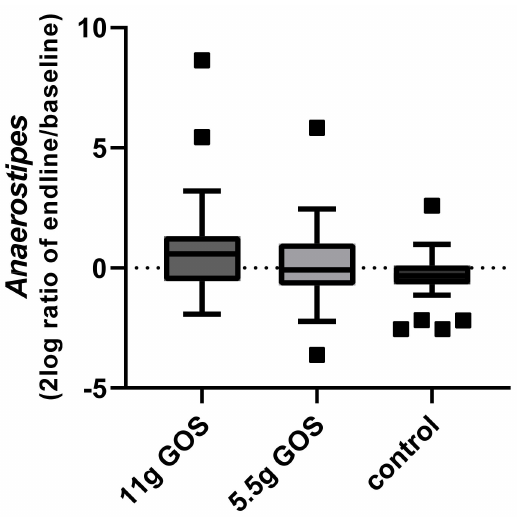
Figure 6. Change in Anaerostipes over time (2log ratio of relative abundance at endline (week 3) and at baseline) for the different study groups. Boxplots are displayed as Tukey